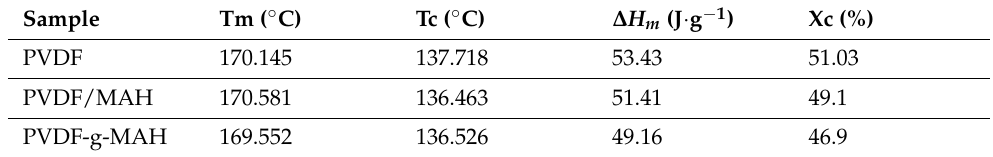
Figure 7. TGA curves of pure PVDF, PVDF/MAH and PVDF-g-MAH (G = 0.63%) under a nitrogen atmosphere: ( a ), TG; ( b ), DTG. Table 2. TGA data for PVDF, PVDF/MAH and PVDF-g-MAH. Sample